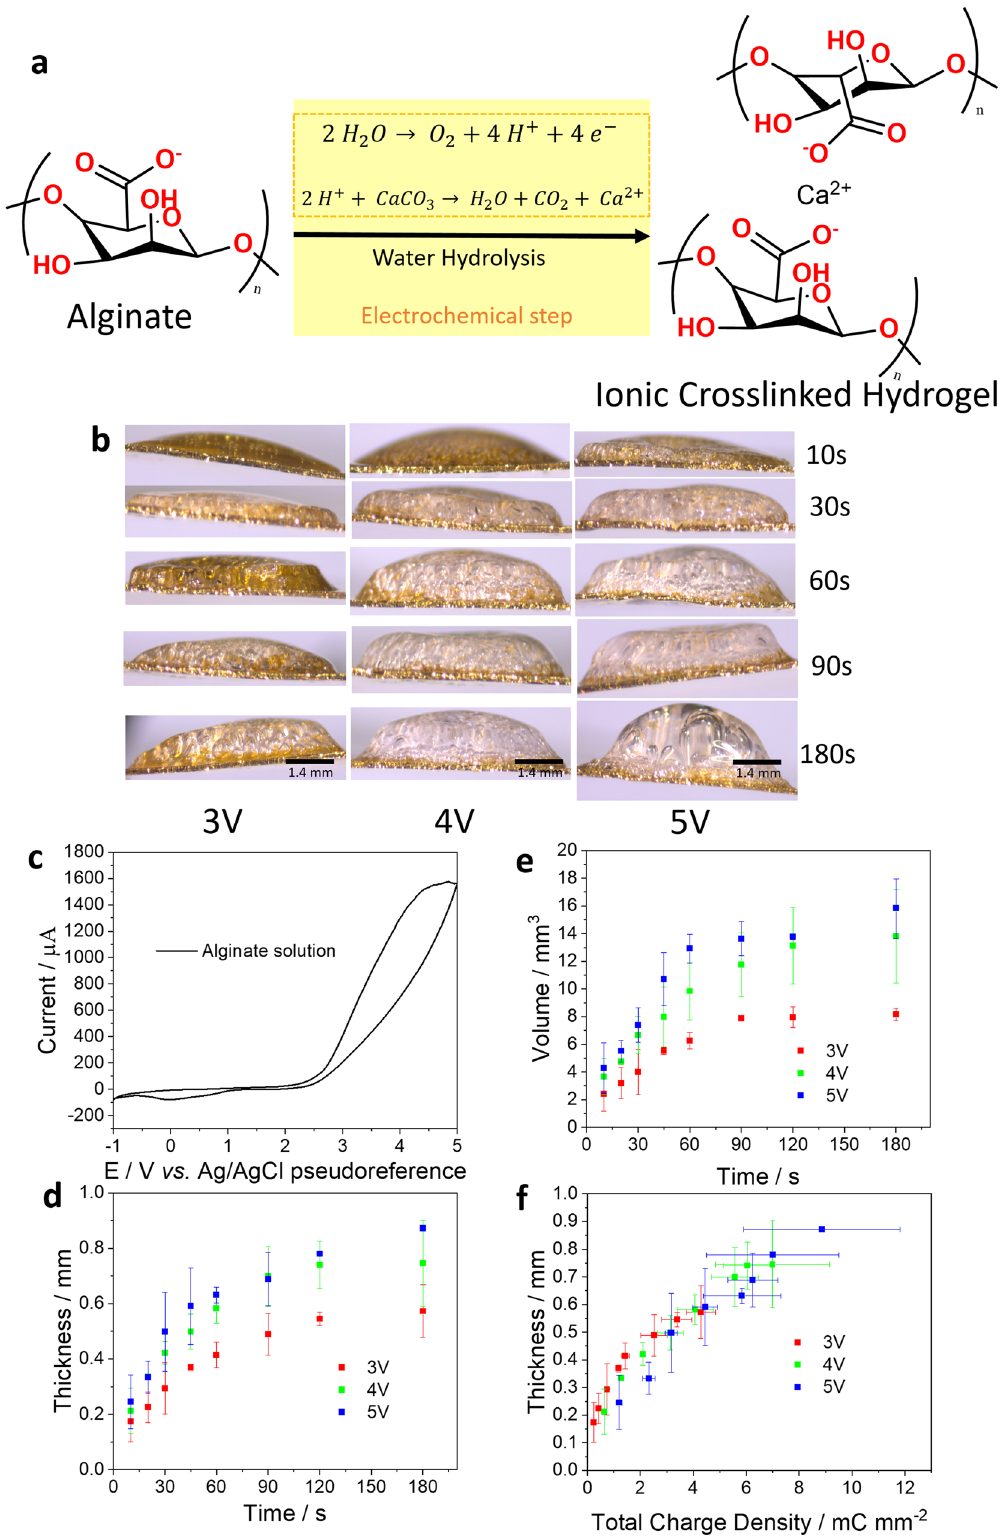
small EDOT monomers. This is consistent with our observation that the PEDOT/alginate hybrid forms at a much slower rate. The electrodeposition rate may be further limited by slow diffusion of EDOT monomers in the viscous alginate solution. A PEDOT/ alginate hydrogel covering the available WE area was observed to take approximately 6